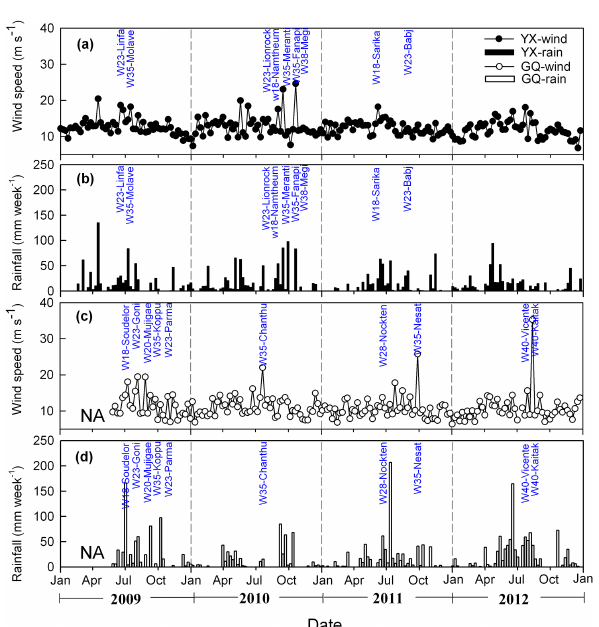
Figure 2. (a, c) Maximum wind speed, (b, d) total weekly rain- fall for Yunxiao (YX) and Gaoqiao (GQ) during a 4-year period between 2009 and 2012. The name and occurrence date of each ty- phoon are also shown.